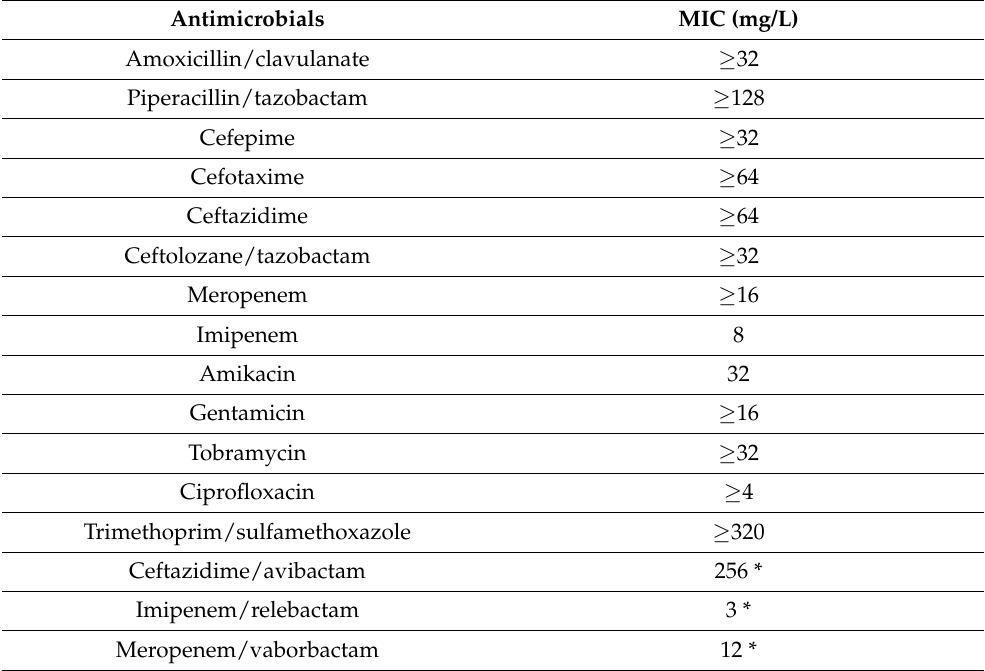
Table 1. Antimicrobial susceptibility test of